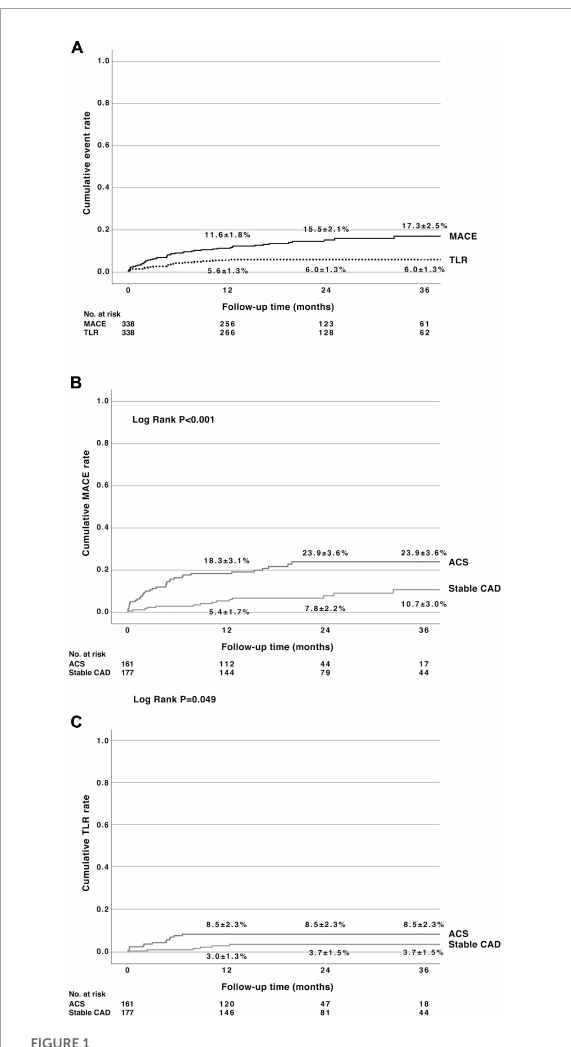
rate after percutaneous coronary intervention using paclitaxel drug-coated balloon with citrate ester excipient as an excipient. (B) Cumulative MACE rate in patients with stable coronary artery disease (CAD) or having acute coronary syndromes